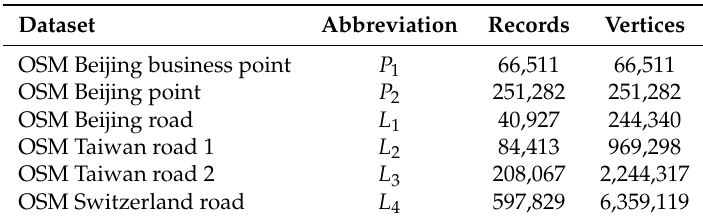
Table 3. Datasets used in the experiment. OSM: OpenStreetMap .